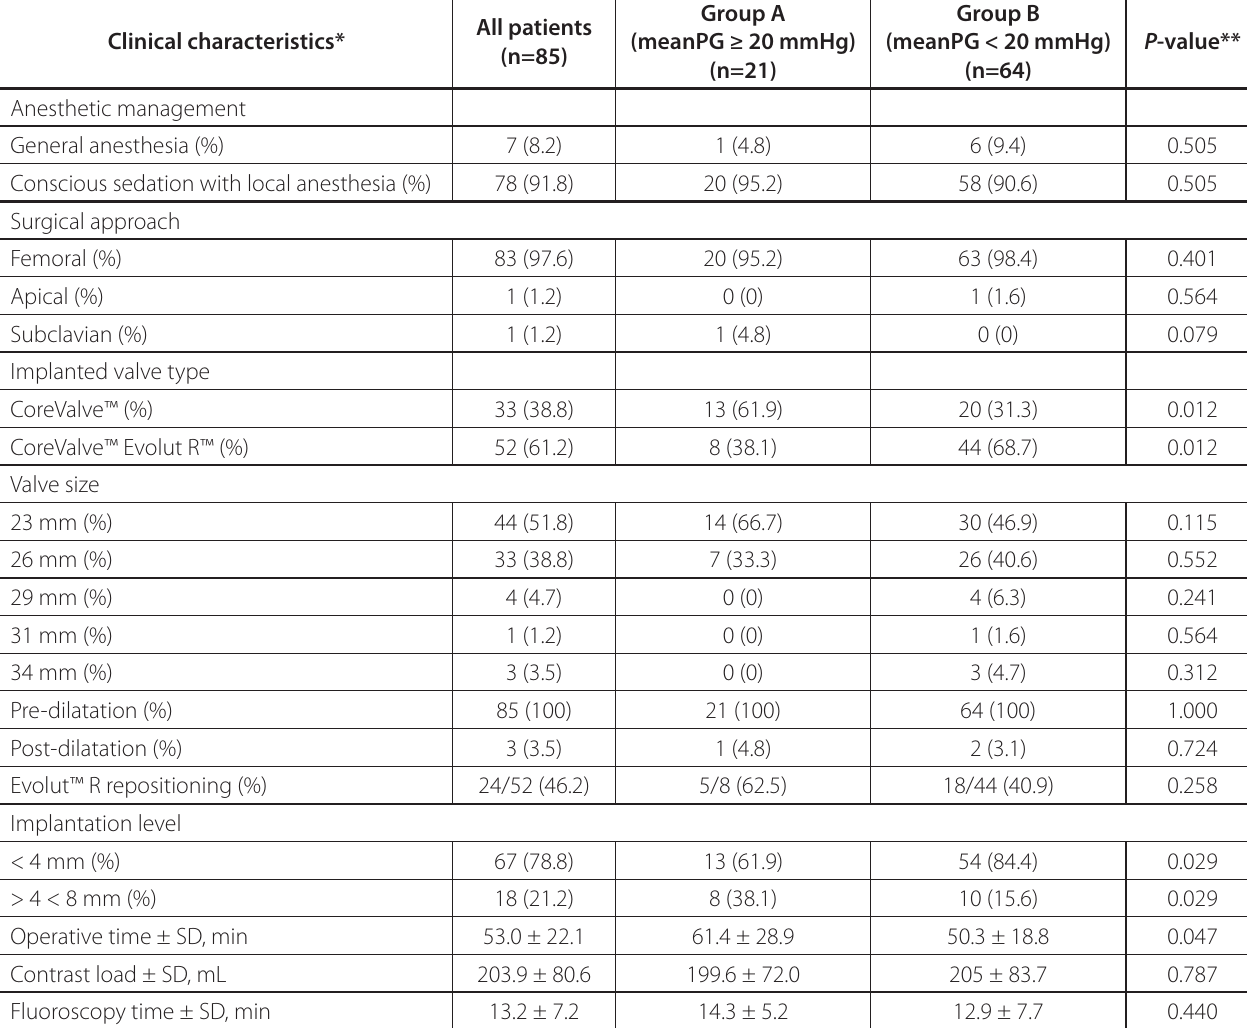
Table 2 . Technical